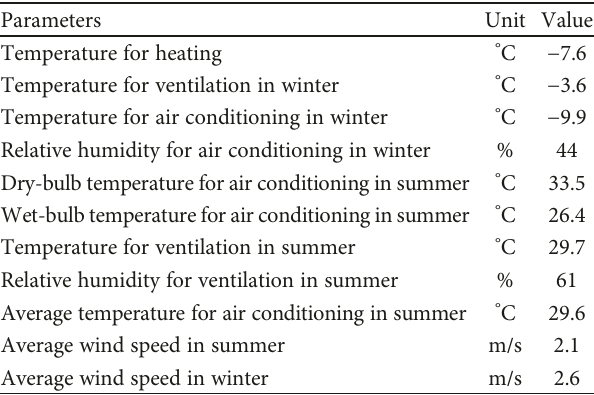
Table 2: Outdoor climate parameters for system design in